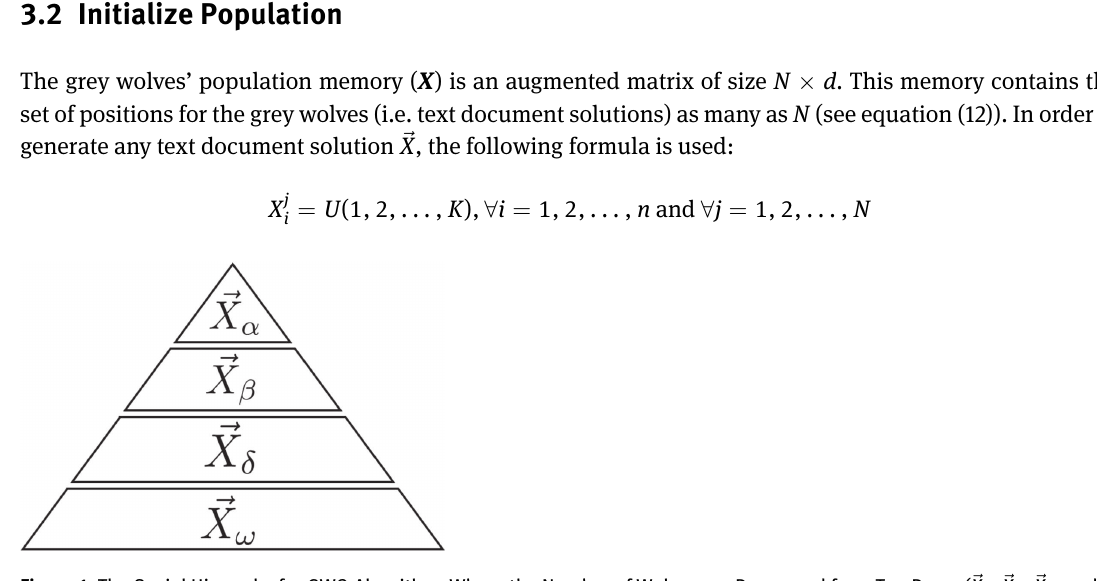
Figure 1: The Social Hierarchy for GWO Algorithm, Where the Number of Wolves are Decreased from Top Down ( ⃗ X α , ⃗ X β , ⃗ X δ , and ⃗ X ω ),